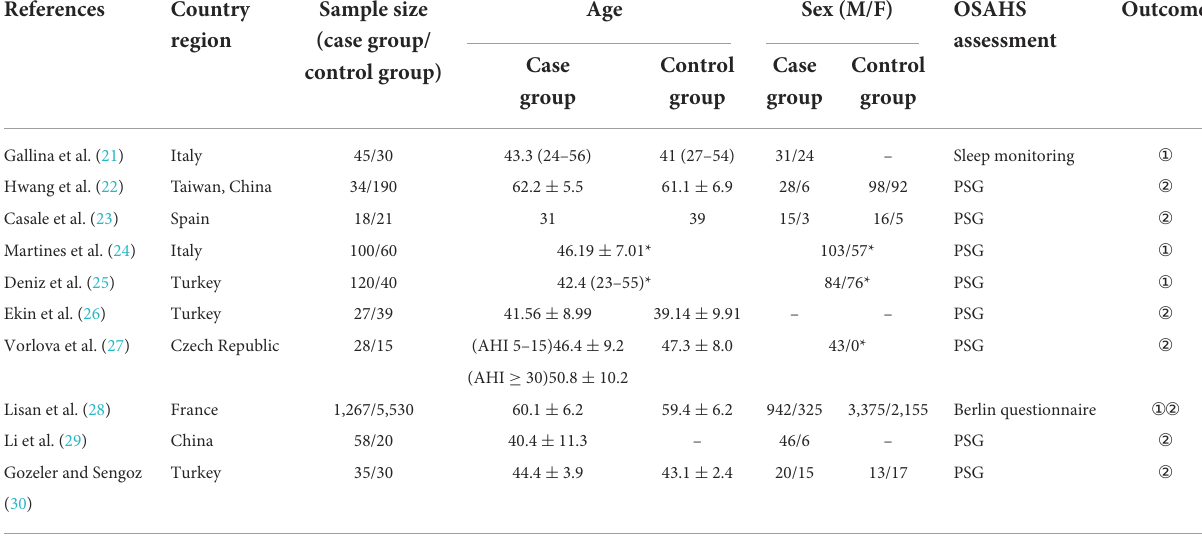
TABLE 1 Basic features of the included studies.